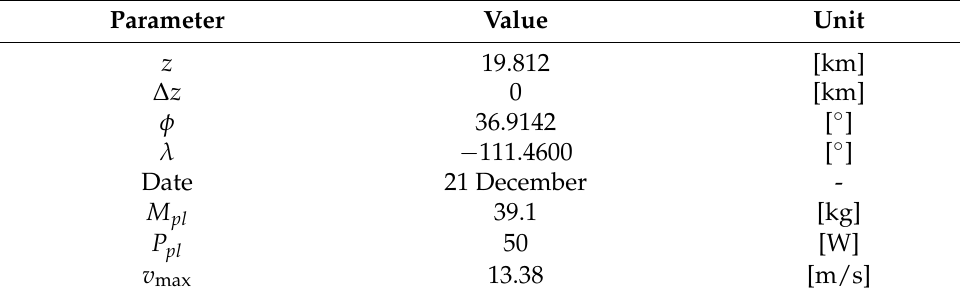
Table 2. Parameters for the sizing tool validation on the HiSentinel80.